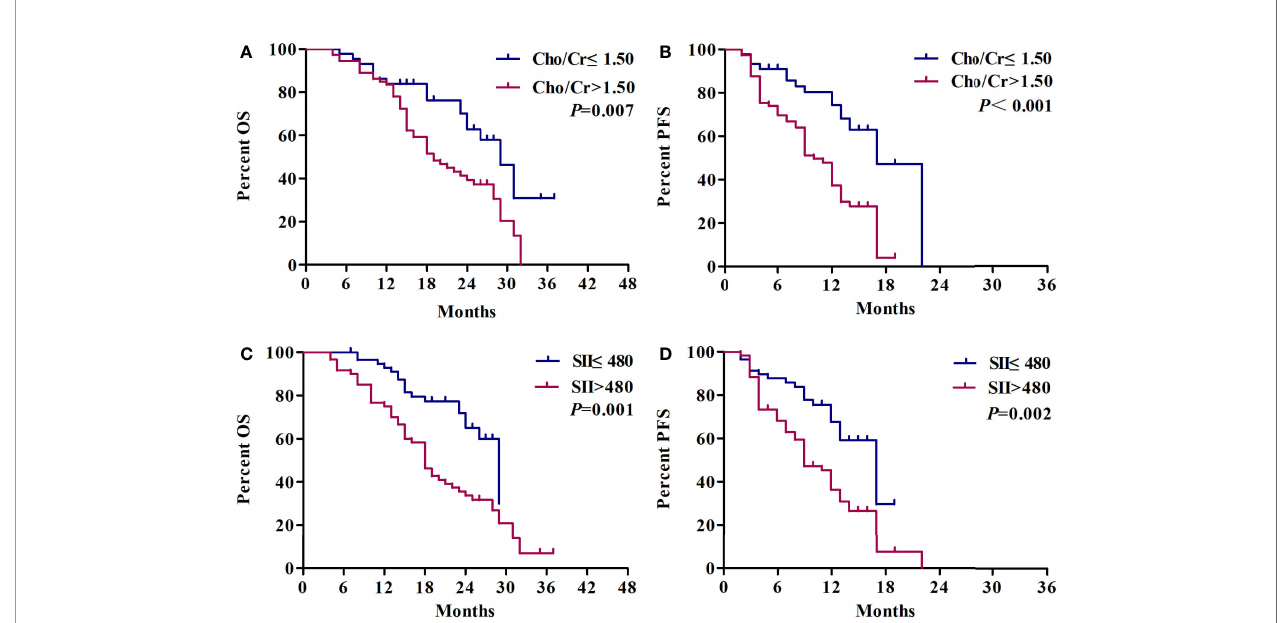
FIGURE 6 | Kaplan – Meier survival curves of Cho/Cr and SII in NSCLC patients with brain metastases. (A) Overall survival curves of Cho/Cr. (B) Progression-free survival curves of Cho/Cr. (C) Overall survival curves of SII. (D) Progression-free survival curves of SII. Cho, choline; Cr, creatine; SII, systemic immune-in fl ammation index.